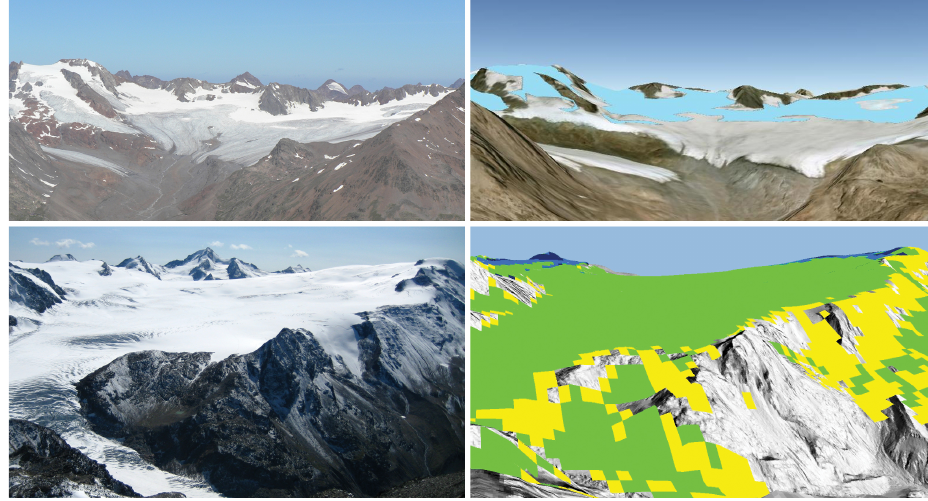
Fig. 7. 3-D comparison of observed and simulated snow patterns from 15 August 2009 at Vernagtferner illustrated using Google Earth (upper row); simulated classified snow cover from 3 September 2003 on the glacier Gepatschferner based on a laserscan DEM (lower row, SWE-values: yellow 0–10mm, green 10–100mm and blue >